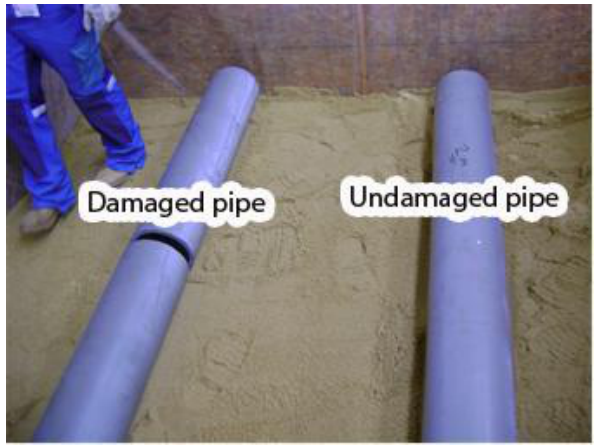
Figure 2: Arrangement of the two plastic pipes in the test box prior to burial